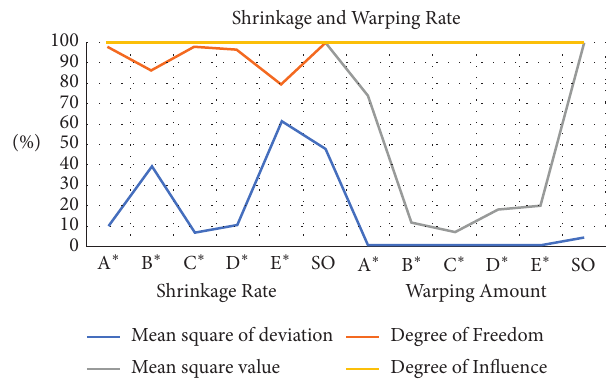
Figure 6: Result of